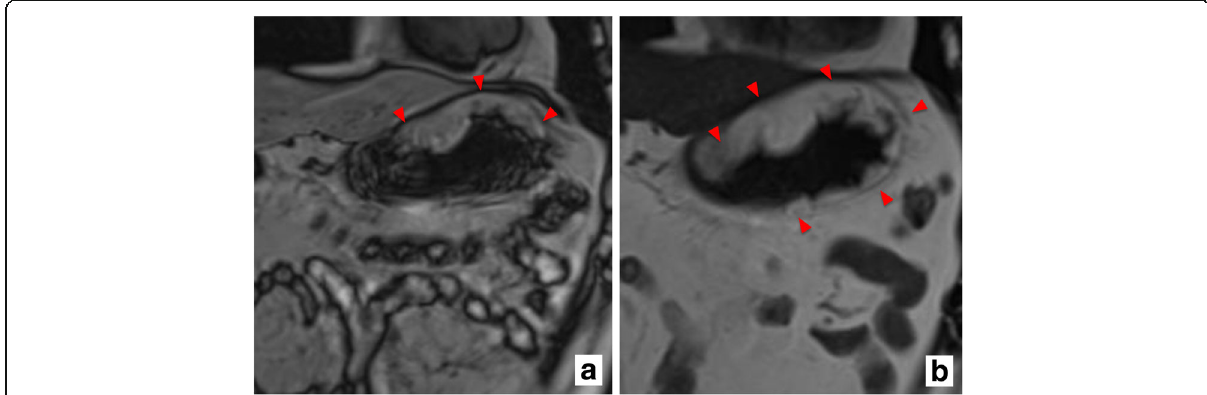
Fig. 3 Findings on T1- and T2-weighted MRI. T1- ( a ) and T2-weighted ( b ) MRI findings are shown. There is a high-intensity lesion in the submucosa with a fat-containing mass on the entire wall of the gastric antrum and body, but excluding the lesser curvature (red